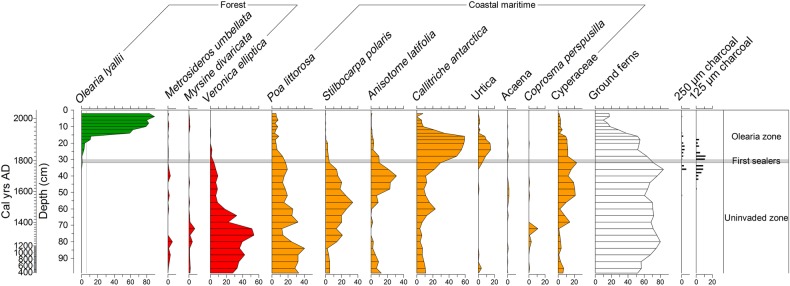
Summary percentage pollen record from Ewing Island, with pollen taxa plotted against depth, with the calibrated age scale in years AD shown on the secondary axis. Grey zone shows time of earliest sealing activity in the region (1807–10).